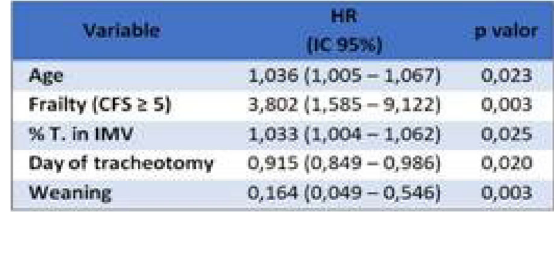
Fig. 2 (abstract 001029). Representative waveforms of a patient before and after PEEP titration according to transpulmonary pressure measurement.